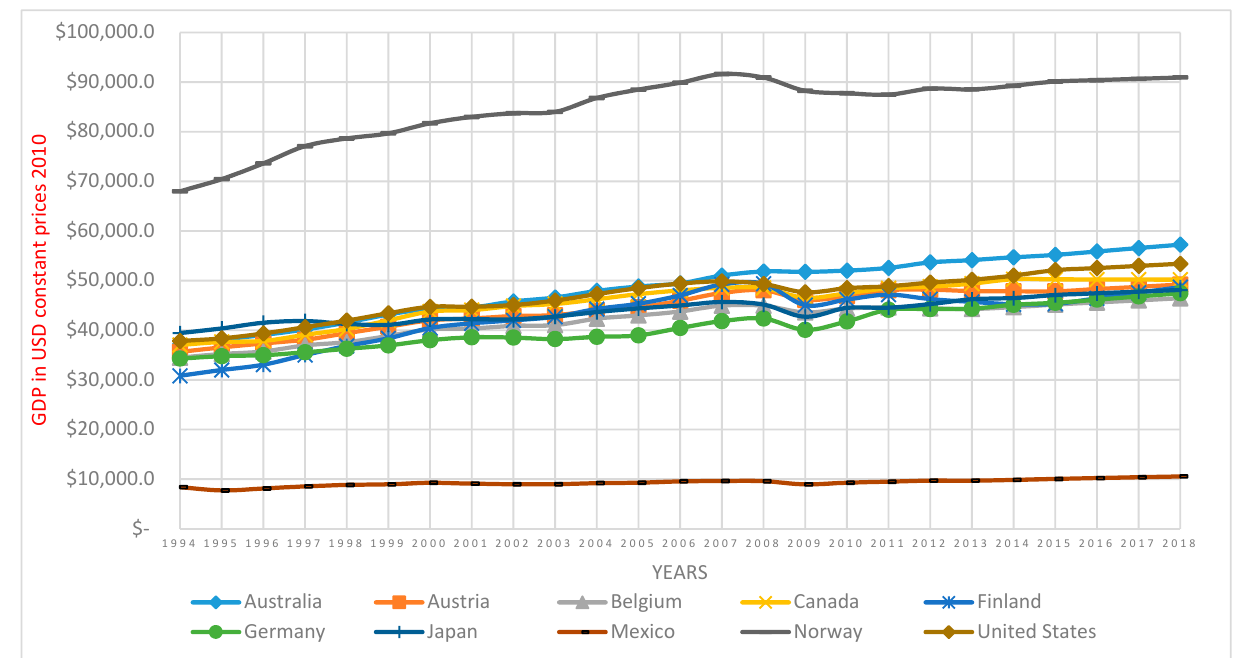
Figure A1. Ten OECD countries’ GDP in US dollars—2010 constant prices. Urbanization: According to Britannica 2020 reports, urbanization is the procedure due to which large number of people permanently shift to and settle in relatively small areas, resulting in the formation of cities. Here, it is a share of urban population of total population (%).